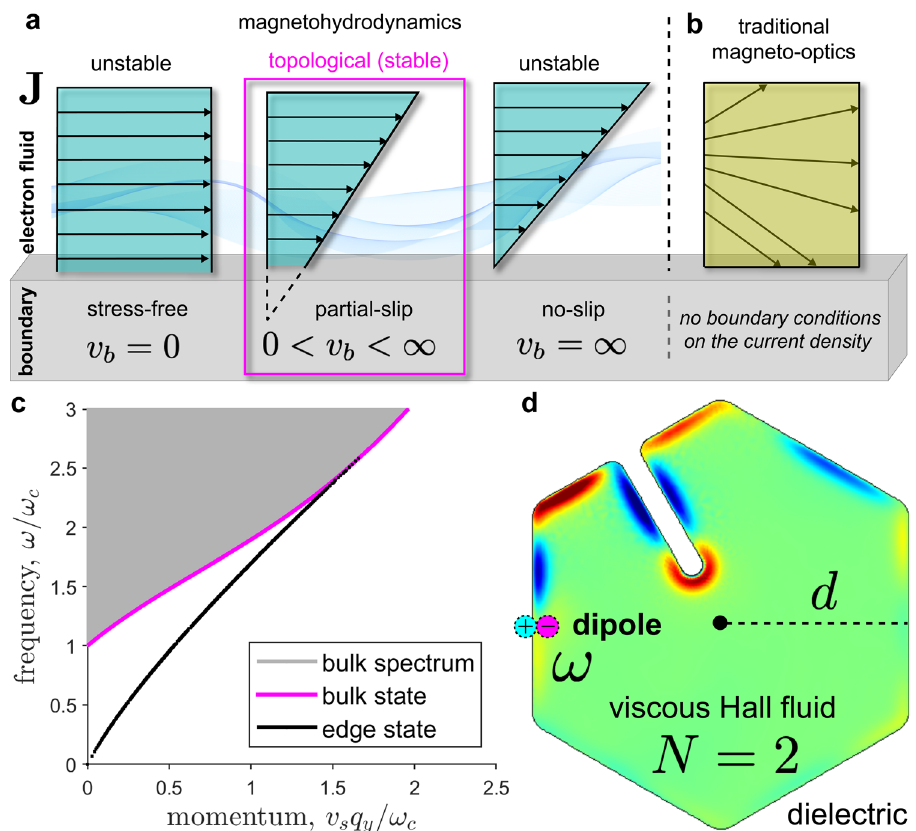
Fig. 4 Boundary layer of the topological viscous Hall fl uid. a Depiction of the additional boundary conditions (ABCs) on the current density J in magnetohydrodynamic systems. The boundary scattering velocity v b dictates the amount of slip at the interface, with v b = 0 and v b = ∞ being the extreme cases of stress-free and no-slip BCs respectively. b Traditional magneto-optics does not consider nonlocal phenomenon and the associated ABCs on J . This theory cannot describe the physics in the hydrodynamic boundary layer. c Bulk and edge dispersion of the dissipationless Γ = 0 nontrivial N = 2 viscous Hall fl uid. No edge states exist in the trivial regime N = 0. Magenta and black lines are the BMP and topological EMP dispersion respectively, ω b ( q y ) and ω q e ( y ). Gray denotes the continuous bulk spectrum. The simulations include the Coulomb interaction and we have imposed arbitrary boundary slip conditions. Topological EMPs exist for all values of the scattering velocity v b . d Numerical simulation of the topological circulator on dielectric substrate. The center to edge length is d = 20 r c = 548 nm. A dipole source is placed at the boundary and oscillates periodically in the band gap at ω /2 π = ∣ ω c ∣ /4 π = 2.26 THz for a total of 1.7 ps. The color plot shows the normalized charge density fl uctuation δρ / ρ 0 where red and blue indicate positive and negative values respectively. The topological edge state navigates sharp defects with zero back-scattering and is immune to boundary